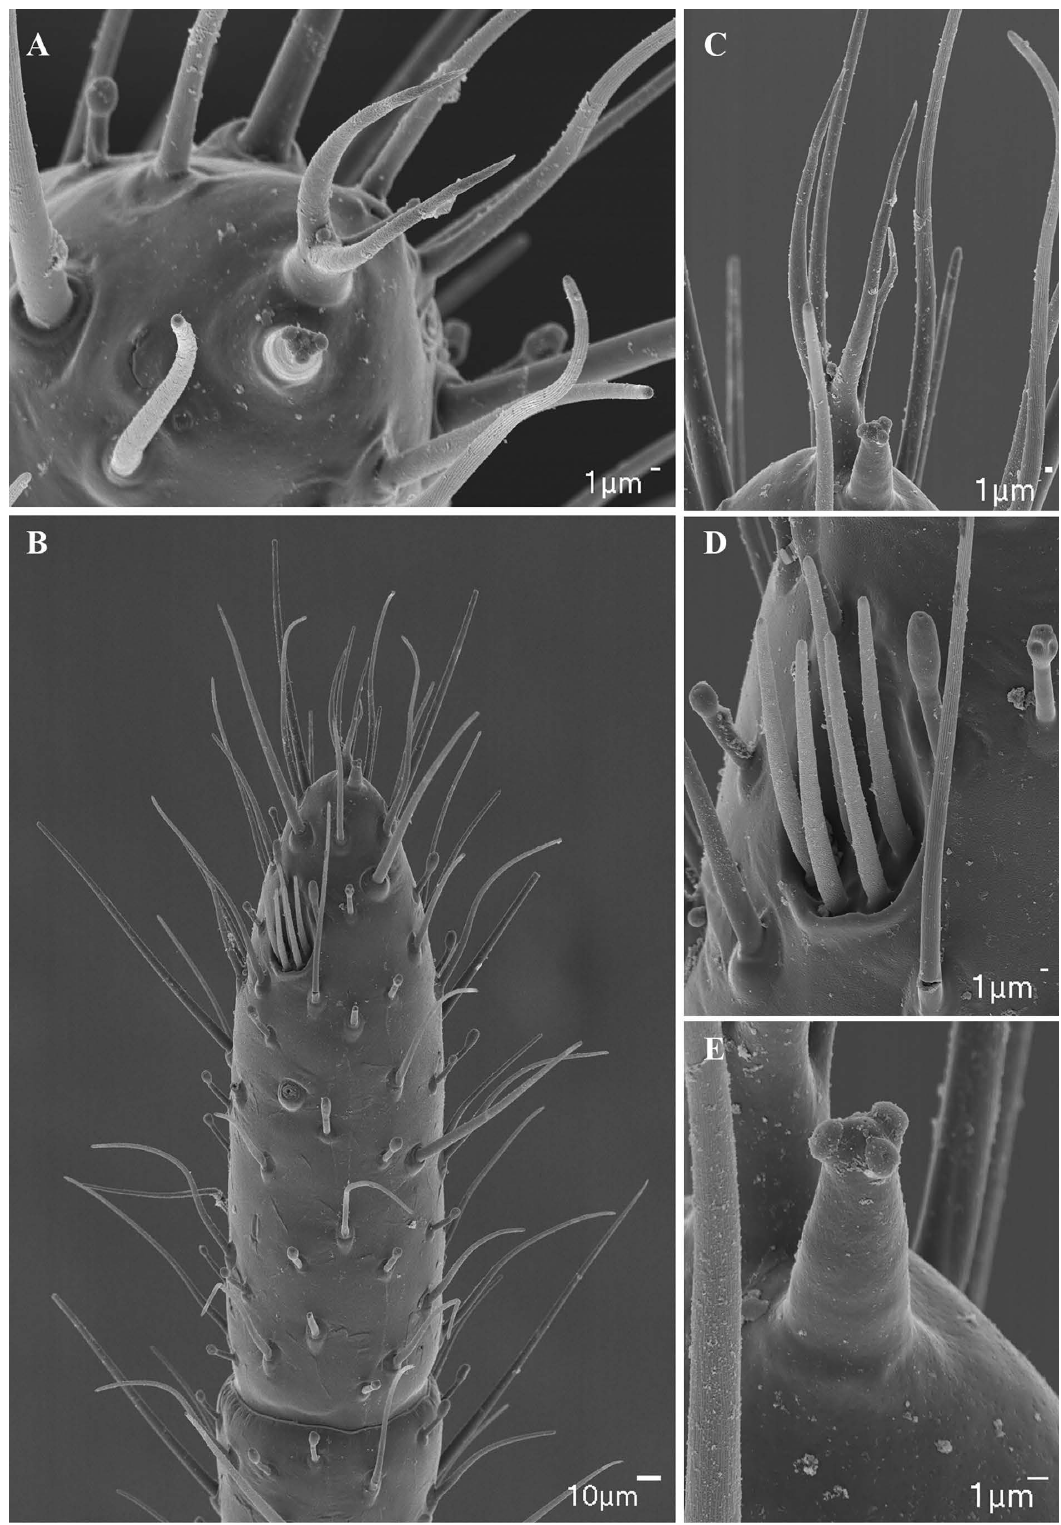
Fig. 134. Sarax yayukae Rahmadi, Harvey & Kojima, 2010 (AMCC [LP 12109]), antenniform leg I, ♂. A . Apex of distal article. B . Distal segment of tarsus, lateral view. C . Apex of distal article of tarsus showing claw and tarsal organ. D . Rod sensilla and olfactory setae. E . Detail of tarsal